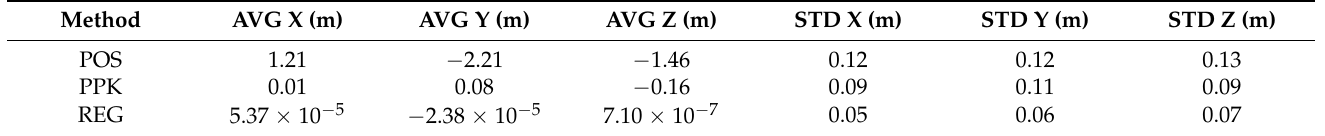
Figure 11. The corresponding point residual errors of the spatial-feature points. ( a ) Results obtained based on UAV airborne POS system. ( b ) Results obtained based on PPK POS data. ( c ) Results obtained based on 3D-model automatic registration. Table 2. Comparison of the positioning accuracy of corresponding points for different 3D